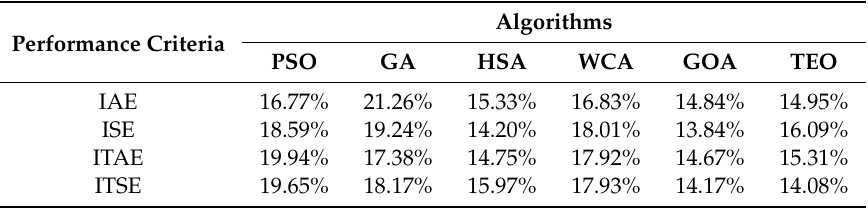
Table 4. Measures of algorithms’ CTE metrics for problem ( 3 5).